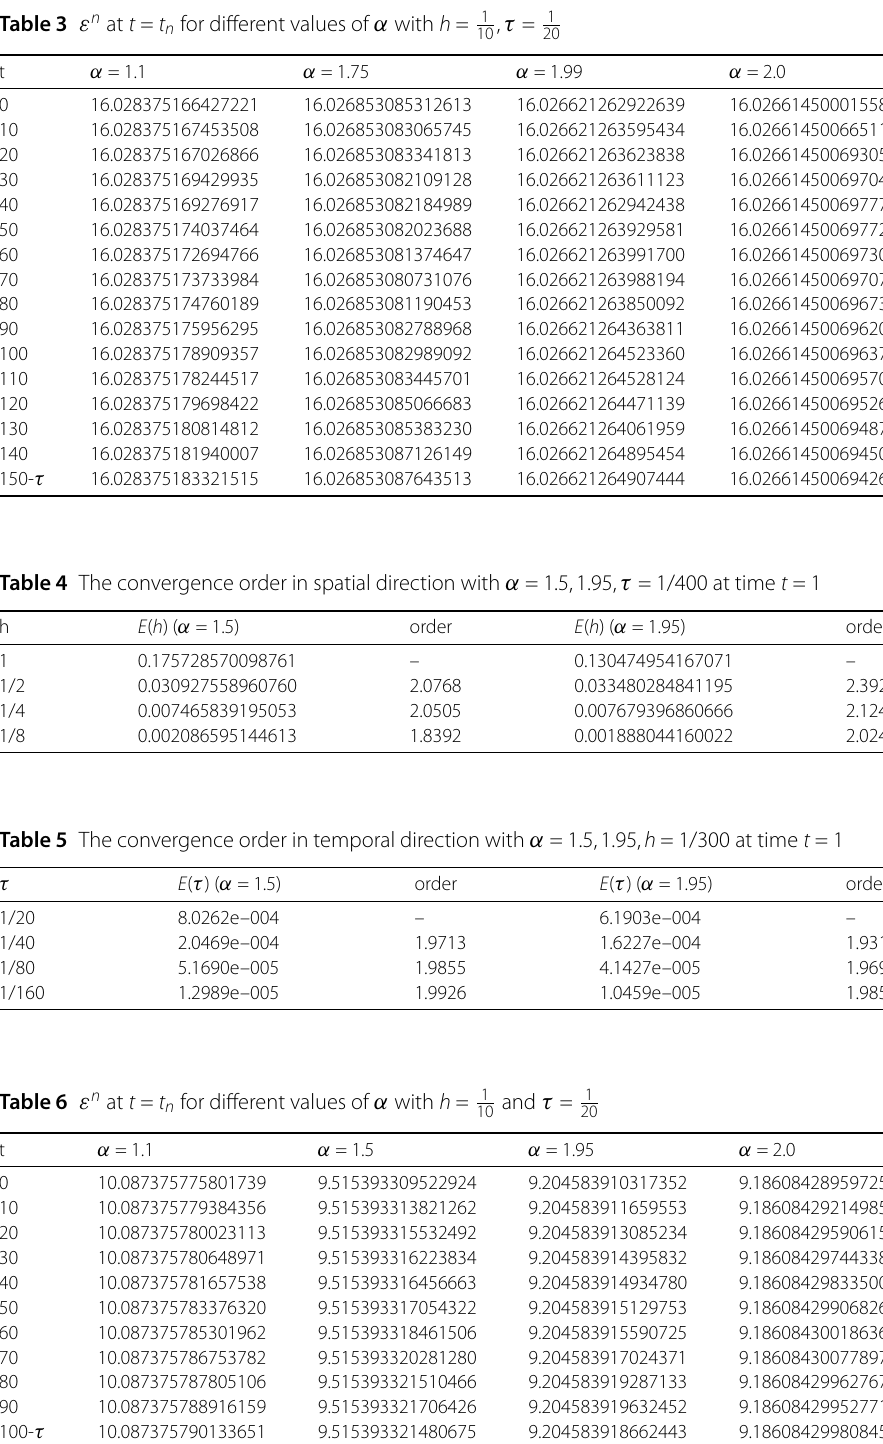
Table 3 ε n at t = t n for different values of α with h = 1